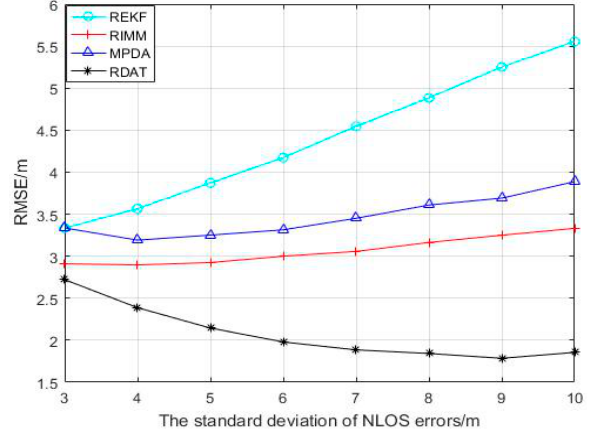
Figure 6. The cumulative distribution function (CDF) result of the localization error.